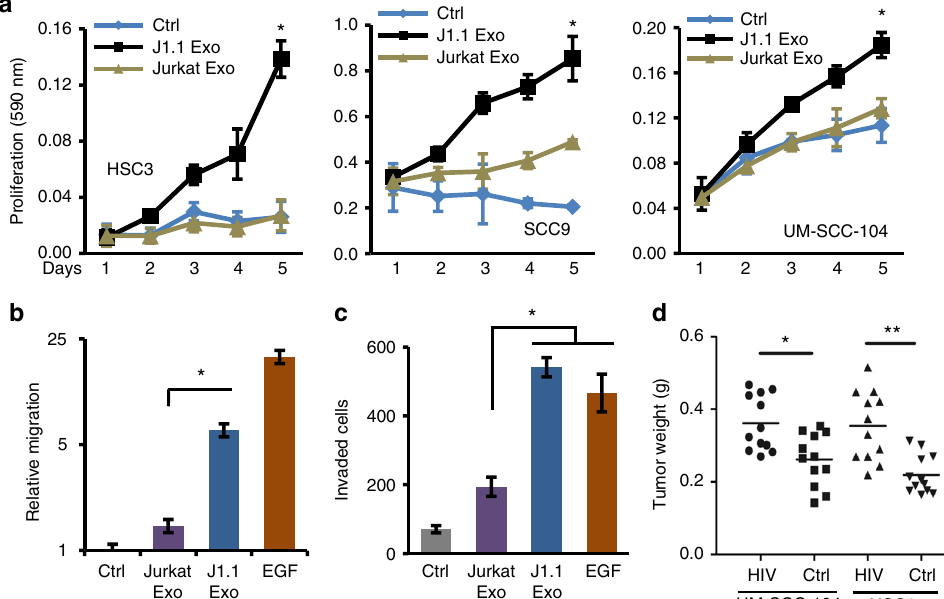
Fig. 2 HIV-infected T-cell exosomes promote cancer cell proliferation and migration. a The effect of exosomes on cell proliferation of HSC3, SCC9, and UM- SCC-104 HNSCC cells treated with 4 × 10 9 exosomes ml − 1 from J1.1 (J1.1 Exo) or Jurkat (Jurkat Exo) cells. Ctrl, serum-free medium. Error bars, ±s.d., n = 3, * p < 0.01, one-way ANOVA on days 3 to 5. b HSC3 cancer cell migration in response to J1.1 (J1.1 Exo) or Jurkat cell exosomes (Jurkat Exo) (4.2 × 10 9 ml − 1 ). Error bars, ± s.d., n = 4, * p < 0.02, F -test. EGF (10 ng ml − 1 ), positive control. Relative migration was determined by migration of treatment over that of control. c Transwell invasion assays of HSC3 cells in response to J1.1 (J1.1 Exo) or Jurkat cell exosomes (Jurkat Exo) (4.2 × 10 9 ml − 1 ) loaded in the lower chamber of the transwell plate. EGF (10 ng ml − 1 ), positive control. Error bars, ± s.d., n = 4, * p < 0.02, F -test. d Tumor weight of UM-SCC-104 and HSC3 cell xenografts in nude mice. Cancer cells (5 × 10 6 ) were mixed with 1.6 × 10 10 ml − 1 of J1.1 or Jurkat cell exosomes and then inoculated into nude mice for the xenograft experiment. Data represent means ± s.d., n = 12, * p < 0.05 and ** p < 0.02, Student ’ s t -test. Data represent one experiment from at least three biological repeats in a , b and Fig. 2a, b) compared with control Jurkat cell exosome treatment. Dose – response results indicated that HSC3 cancer cells prolifer- ated proportionally with higher concentrations of J1.1 cell exosomes, in the range of 2 – 8 × 10 9 exosomes ml − 1 (Supplemen- tary Fig. 2c). Exosomes from J1.1 cells, but not those from Jurkat